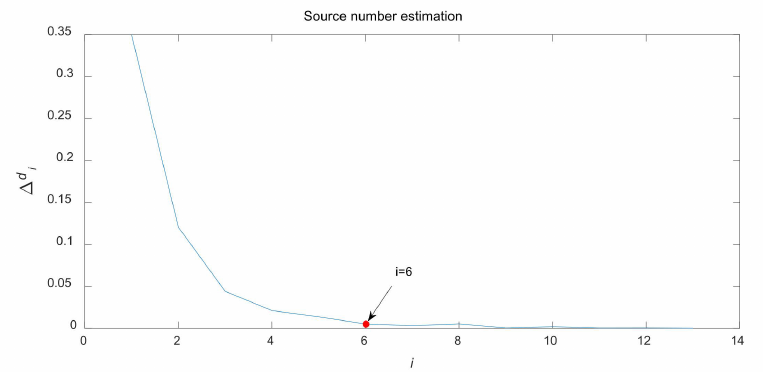
Figure 6. Source number estimation result in linear mixed